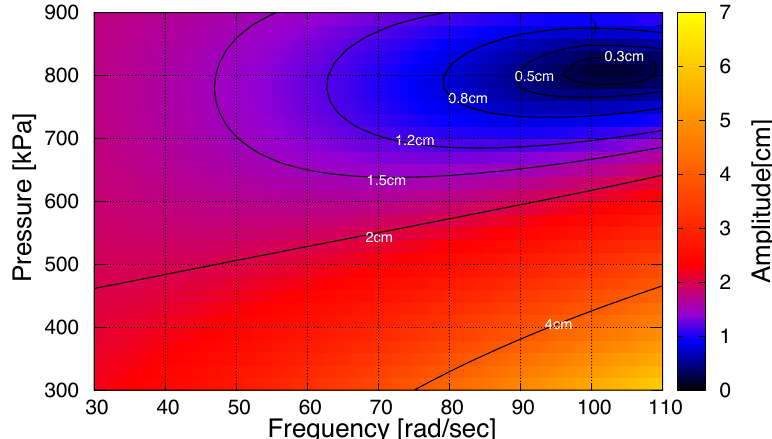
Figure 7. The relationship between the desired periodic movement frequency, the PAM preloaded pressure and the EM displacement (amplitude). Defining ω as the periodic motion frequency, the desired mass position is given by p ( t ) = 0.3 + 0.01sin ( ω t ) .